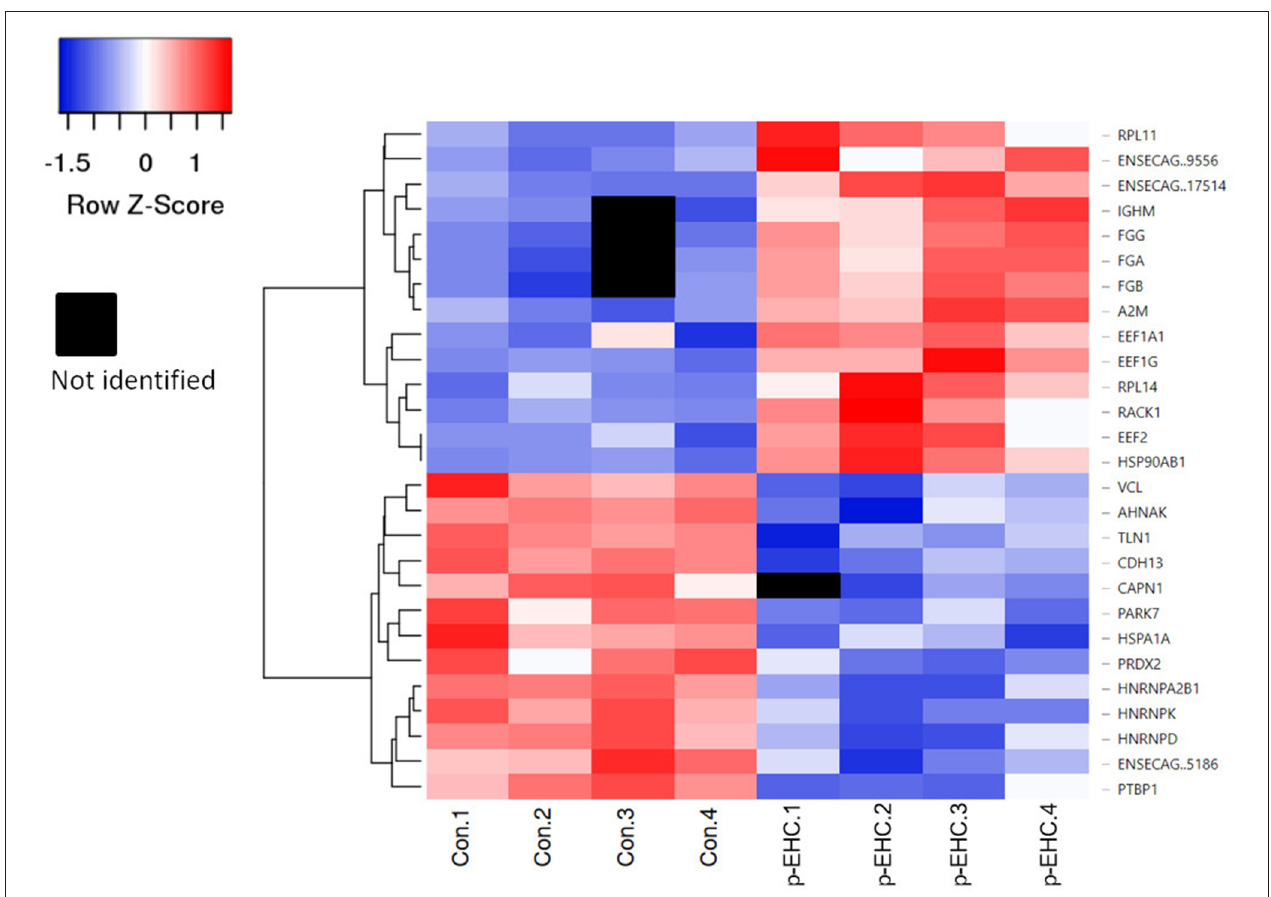
FIGURE 4 | Heat map of significantly differentially expressed proteins in control (Con 1-4) and hyperinsulinemic (p-EHC 1-4) animals. Clustering indicates grouping of proteins by similar expression patterns relative to the mean distance between all objects of the clusters. Red indicates a higher expression, blue indicates a lower expression, while white indicates the least difference between groups and black indicates a lack of data for a specific protein.